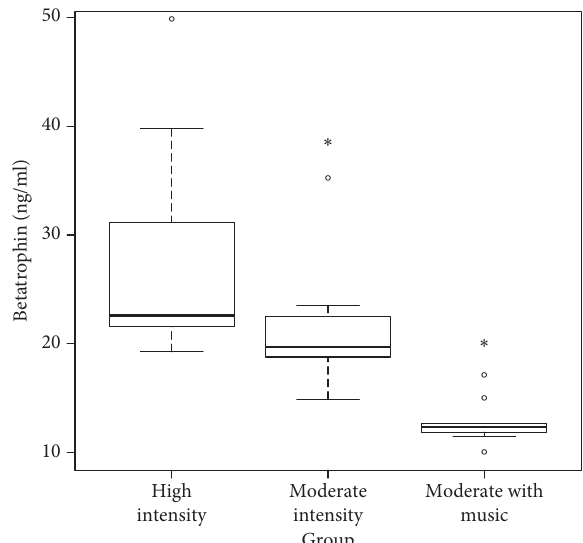
Figure 2: The circulating levels of betatrophin after MIE with musical co-treatment. ∗ Significant vs high-intensity exercise ( p ≤ 0 .